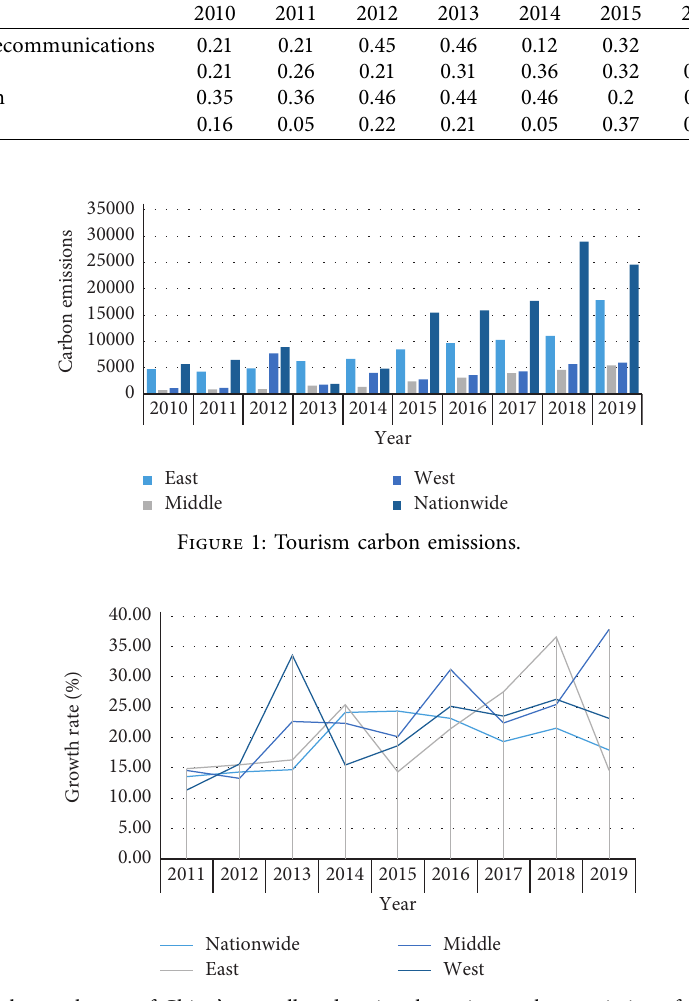
Figure 2: Annual growth rate of China’s overall and regional tourism carbon emissions from 2010 to 2019.